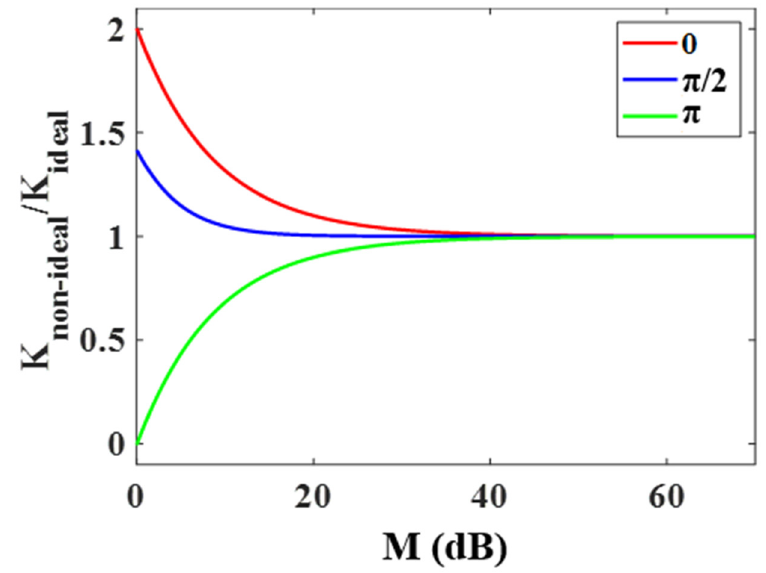
Figure 7. The variation in the amplitude ratio between the nonideal state and the ideal state with the carrier suppression ratio at different phase shift settings.